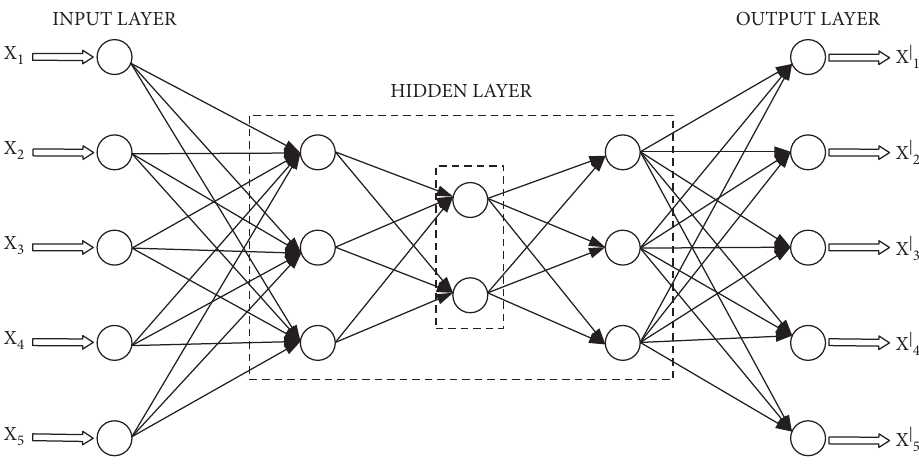
Figure 7: Deep neural network